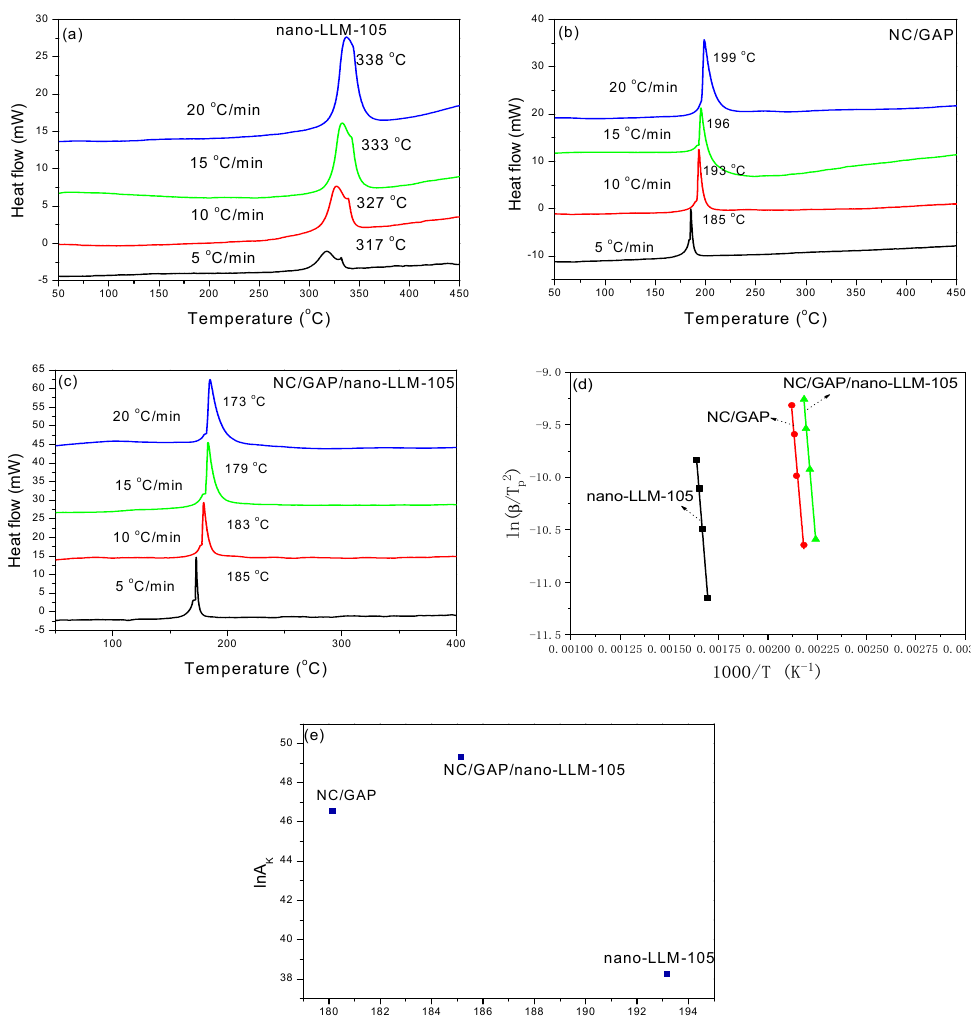
Figure 8. Thermal analyses of the samples. ( a,b,c ) DSC thermograms of samples collected at different heating rates. ( d ) Kissinger plots of ln( β /Tp 2 ) to 1000/Tp; ( e ) for the kinetic compensation effect.